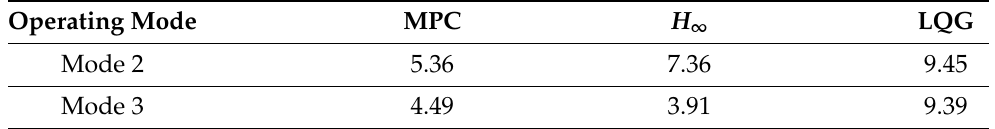
Table 1. Mean of percentage of speed